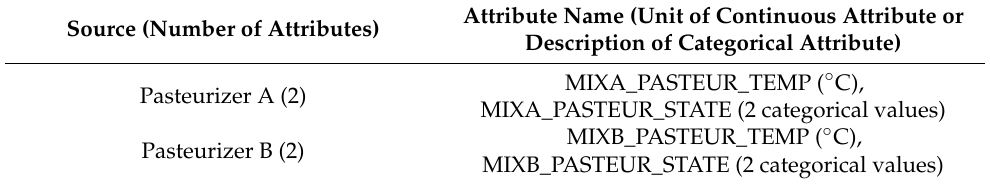
Table 4. Description of attributes in Pasteurizer dataset.